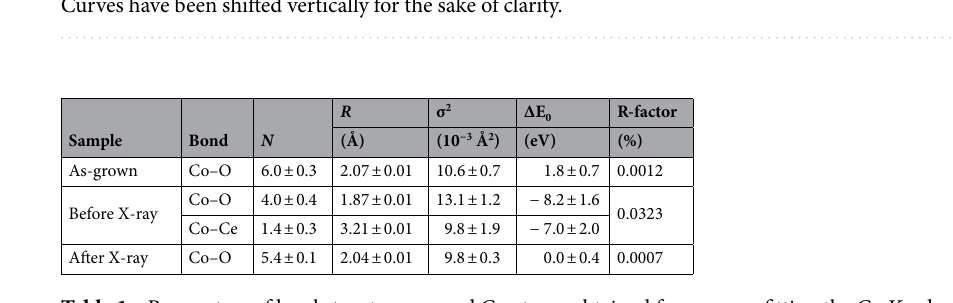
Table 1. Parameters of local structure around Co atoms obtained from curve-fitting the Co K-edge EXAFS.